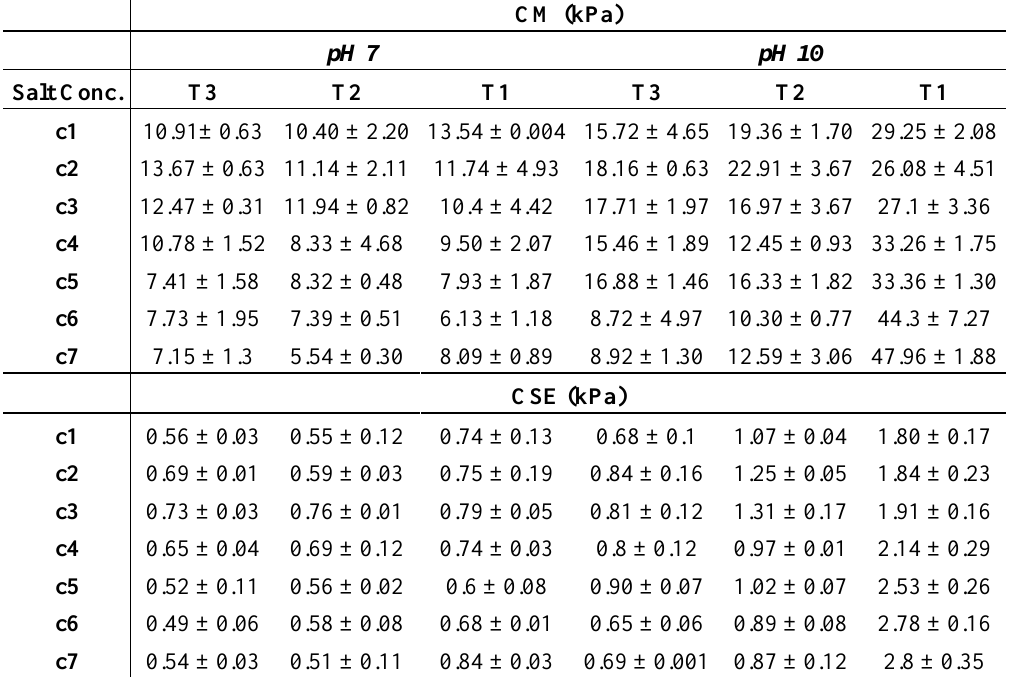
Table 3. CM and CSE as a function of ionic strength (c1, c2, c3, c4, c5, c6, c7), pH (7, 10) and temperature (T1 = 4 °C, T2 = 21 °C, T3 = 37 °C) and expressed as mean ± SD. CM (kPa)